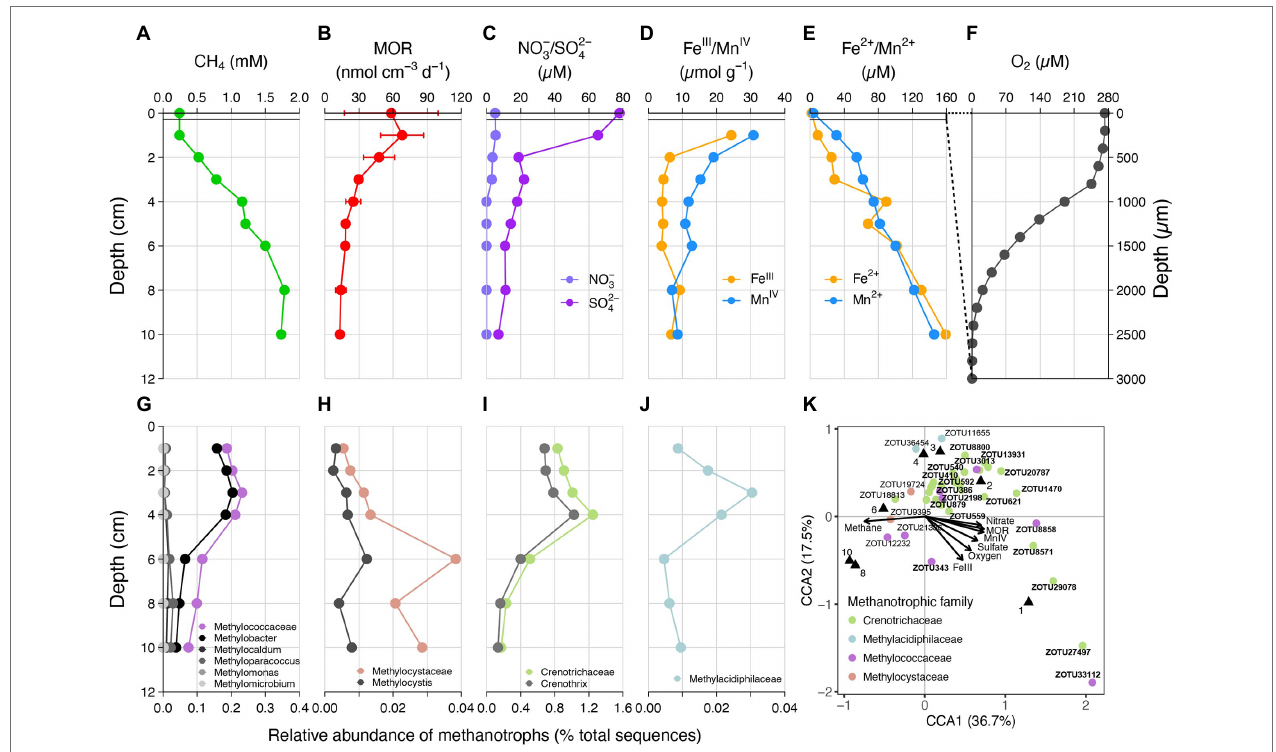
FIGURE 1 | (A–F) Depth profiles of methane, methane oxidation rates (MOR), porewater nitrate/sulfate, particular iron(III)/manganese(IV) oxides, dissolved iron(II)/ manganese(II) and oxygen in the sediment of Lake Sempach. Error bars represent standard deviations of triplicate rate measurements. No nitrite was detected. (G–J) Relative abundances of known families of metahanotrophes and their subgroups at the genus level: (G) Methylococcaceae or Type I gamma-proteobacterial MOB, (H) Methylocystis or Type II alpha-proteobacterial MOB, (I) Crenotrichaceae, (J) Methylacidiphilaceae, (K) canonical correspondence analysis (CCA), showing the relationship between MOR and methanotrophic species and the effect of nutrient concentrations on their distribution. ZOTU abundances were normalized and Hellinger-transformed prior to CCA analysis. A total of 42 ZOTUs accounting for > 92% of the methanotrophic assemblage were used for the analysis, and bold text represents taxa belonging to the genus Methylobacter or Crenothrix . Black triangles denote sediment samples at different